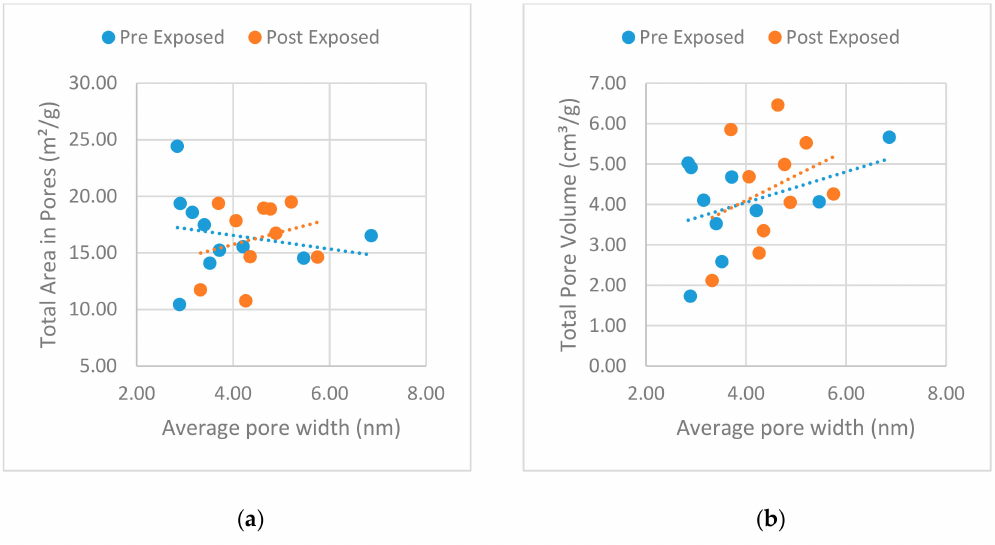
Figure 18. Relationship between average pore width versus total pore area ( a ), and total pore volume ( b ) from LPNA